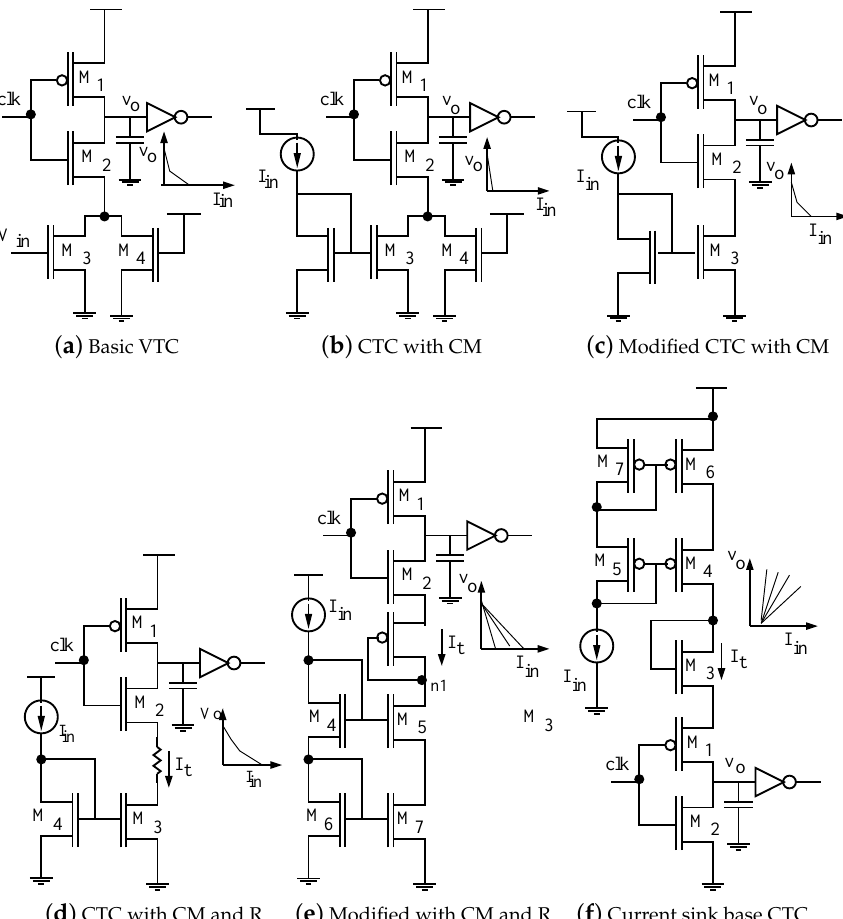
Figure 3. Circuit diagrams of the conventional and proposed CM based VTCs and proposed